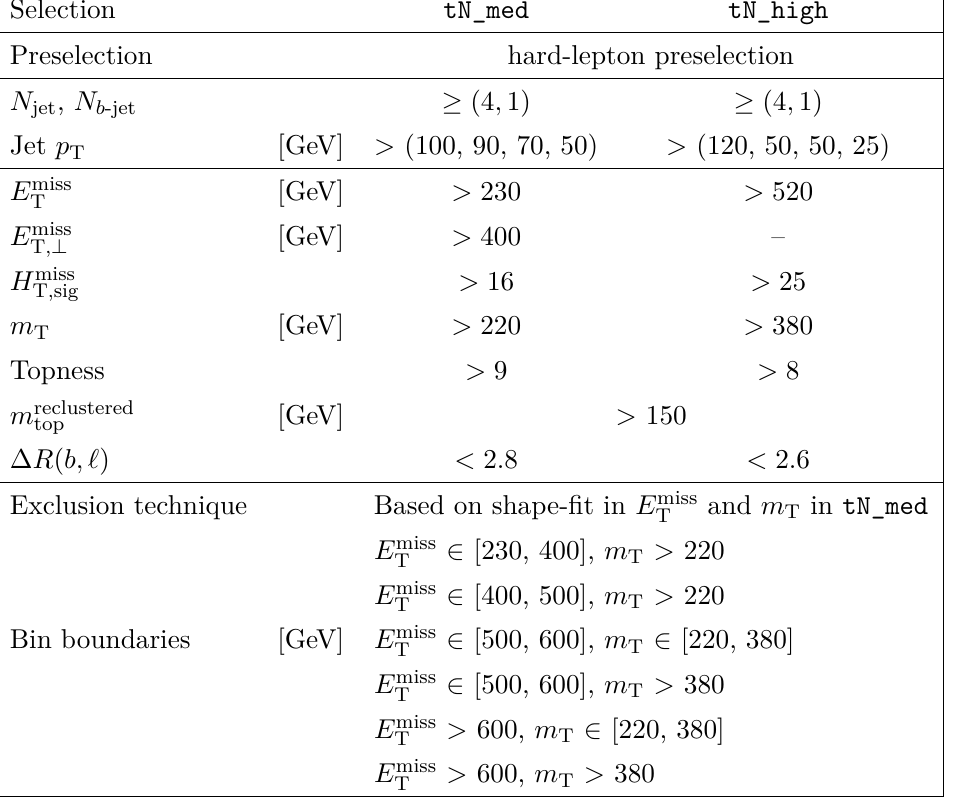
Table 4. Event selections defining the signal regions tN_med and tN_high